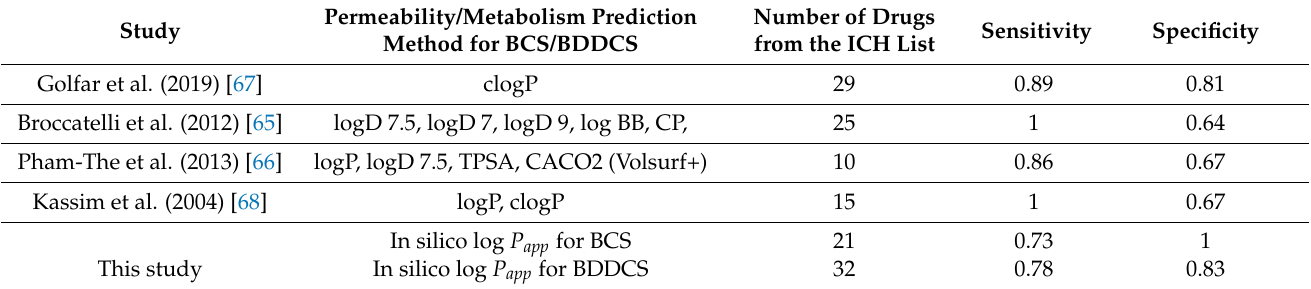
Table 4. Comparison of the performance of this study and previously published models on the ICH drug list.